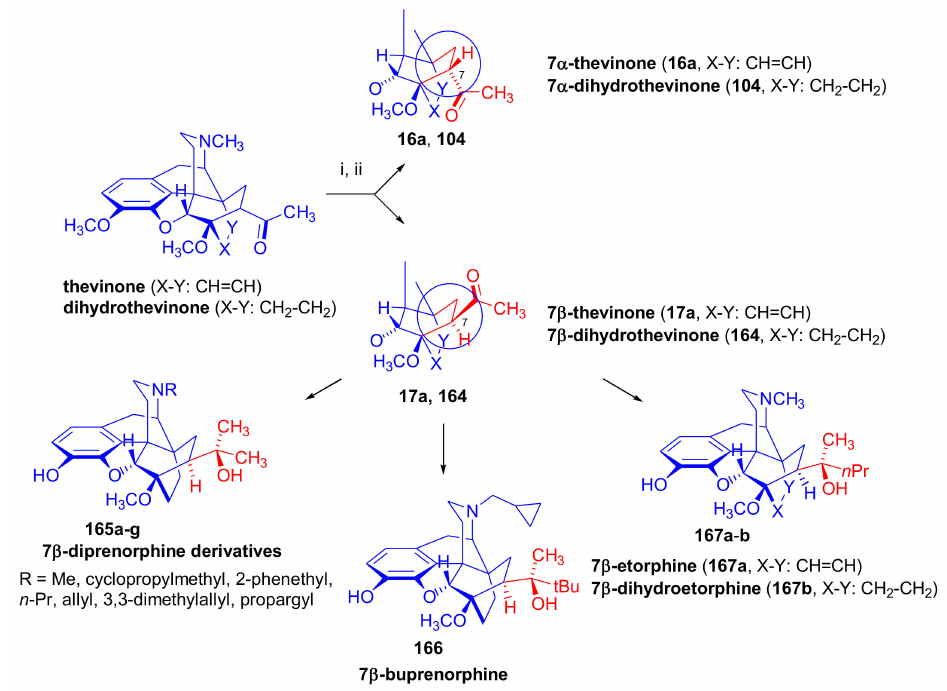
Figure 43. Separation of thevinone isomers and structures of 7 β -diprenorphine analogues, 7 β - buprenorphine, 7 β -etorphine, and 7 β -dihydroetorphine. Reagents and conditions : (i): isomerization; (ii): separation by fractional